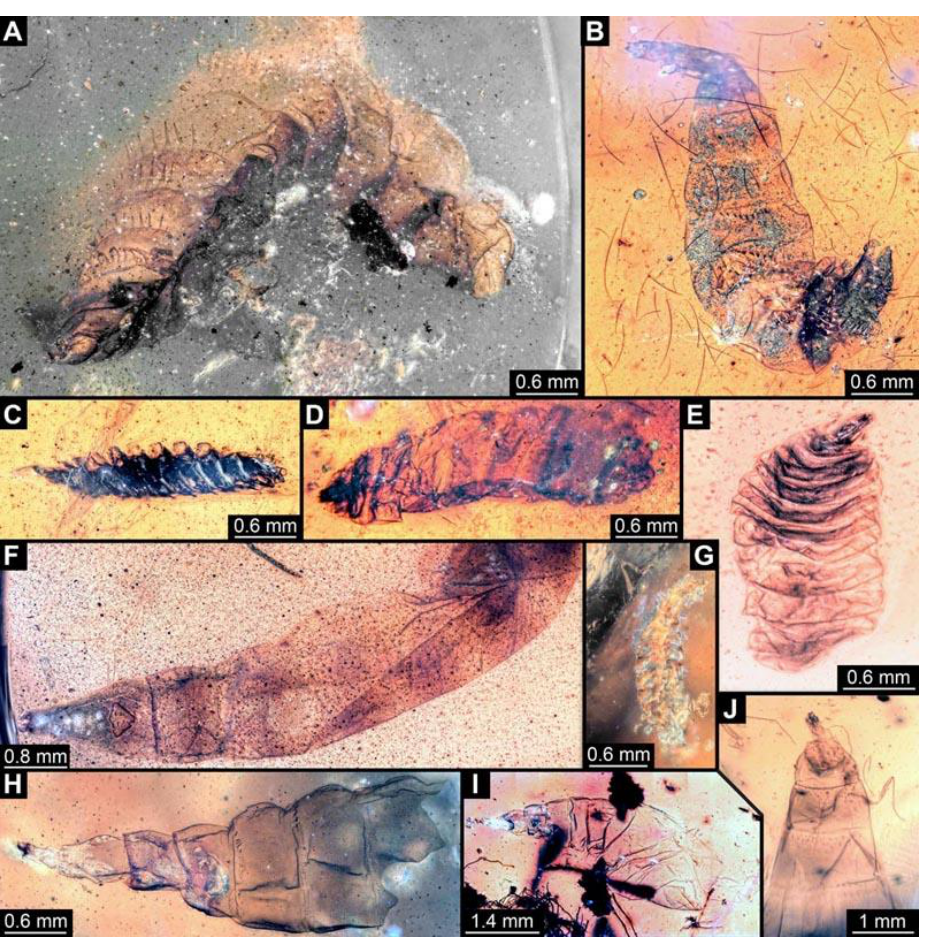
Figure 7. Several fossil larvae. ( A ). PED 0511. ( B ). PED 0628. ( C ). PED 0723. ( D ). PED 1188. ( E ). PED 1349. ( F ). PED 0490. ( G ). PED 0548. ( H ). PED 0714. ( I ). PED 0567-1. ( J ). PED 0567-3. (11) PED 0714: Specimen torn apart in the trunk region, only head capsule, thorax and abdomen segments 1 and 2 visible and well-preserved. (Figure 7H). Surface structure apparent. One anterior spiracle apparent in prothorax. Short spine-like setae on thorax segments and longer ventral spine-like setae on abdomen segments well developed. Total body length could not be measured. Dimensions: body width 1.39 mm, head capsule length 0.98 mm, head capsule width 0.15 mm. (12) PED 0567-1: Specimen ripped apart at the posterior end (Figure 7I), therefore total body length could not be reliably measured. Surface structure apparent. Head capsule well preserved. Dimensions: body width 1.2 mm, head capsule length 0.57 mm, head capsule width 0.15 mm. (13) PED 0567-3: Specimen cut off at the edge of the amber, only prothorax, mesothorax, metathorax and abdomen segment 1 apparent (Figure 7J). Head capsule well preserved. Short spine-like setae on thorax segments well developed. Dimensions: body width 1.7 mm, head capsule length 1.08 mm, head capsule width 0.32 mm. (14) PED 0497: Specimen accessible in dorsal and ventral view, better visible in dorsal the head capsule, which is only visible with transmitted light and enhanced brightness (Figure 8A). Short spine-like setae on thorax segments well developed. Paired posterior spiracles in trunk end. Trunk is bent by about 90 ◦ in the middle, so the total body length could not reliably be measured. Dimensions: body width 1.67 mm, head capsule length 1.8 mm, head capsule width 0.5